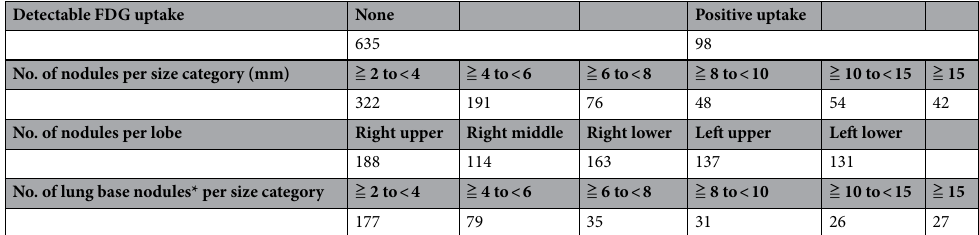
Table 3. Nodule characteristics. *Nodules located lower than either the bifurcation of right middle lobe and right lower lobe bronchus, or the bifurcation of left lingular bronchus and left lower lobe bronchus.